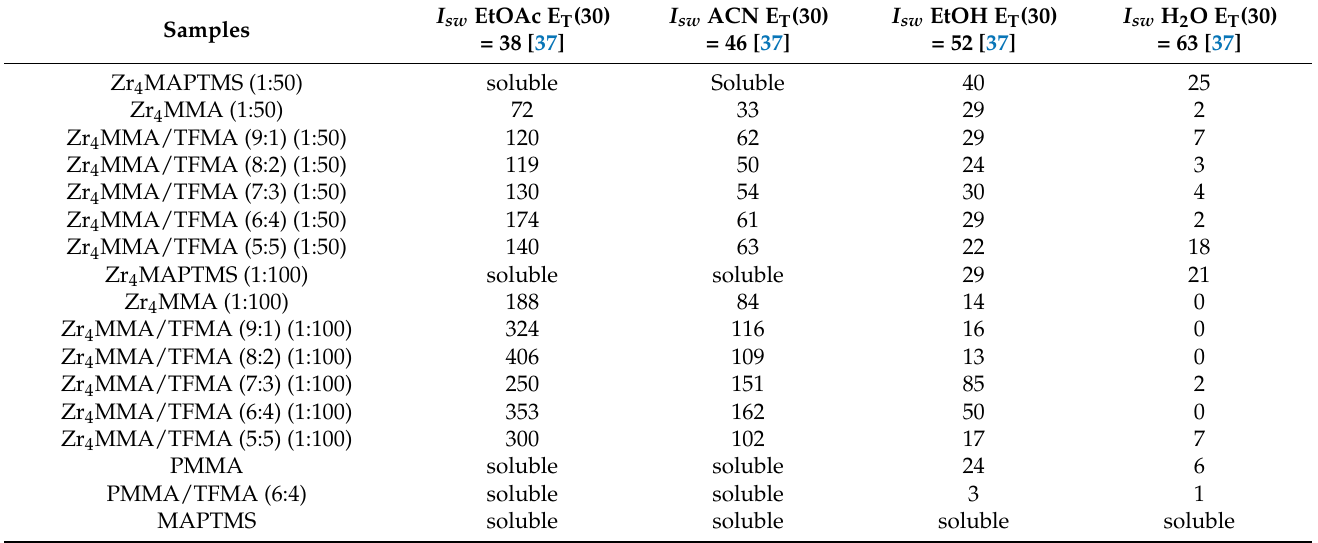
Table 3. Swelling data of the hybrids materials in four different